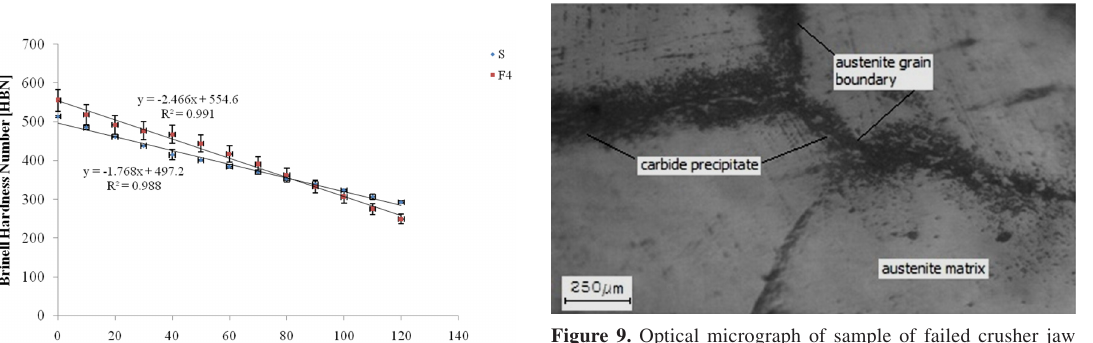
Figure 4. Hardness Value vs Depth for S and F3.